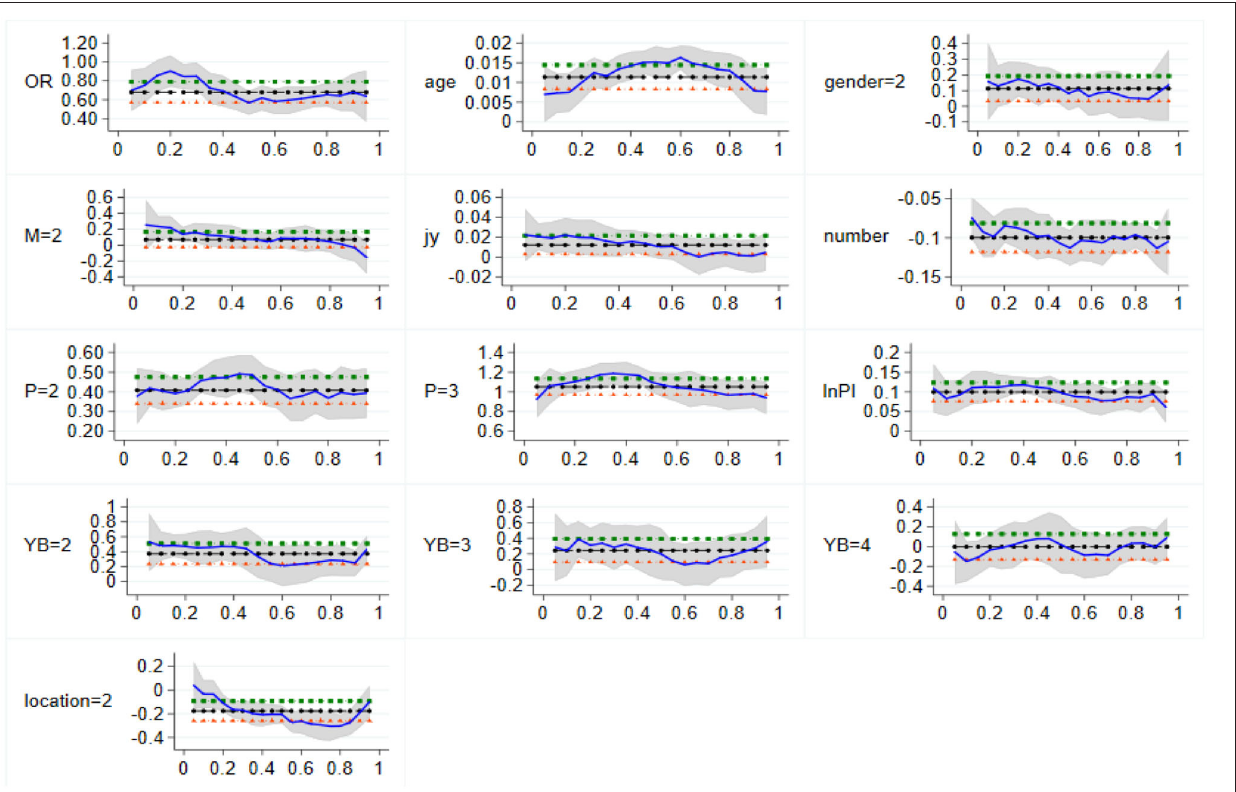
FIGURE 2 | Variation of quantile regression coefficients in Eastern China. The vertical coordinate is the estimated value, whereas the horizontal coordinate is the different quantiles.